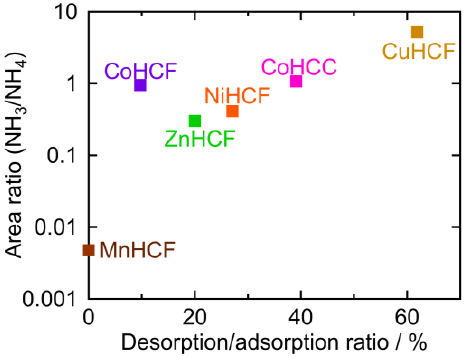
Figure 8. The area ratio of the M-NH 3 and NH 4 peak as observed in the FTIR spectra.